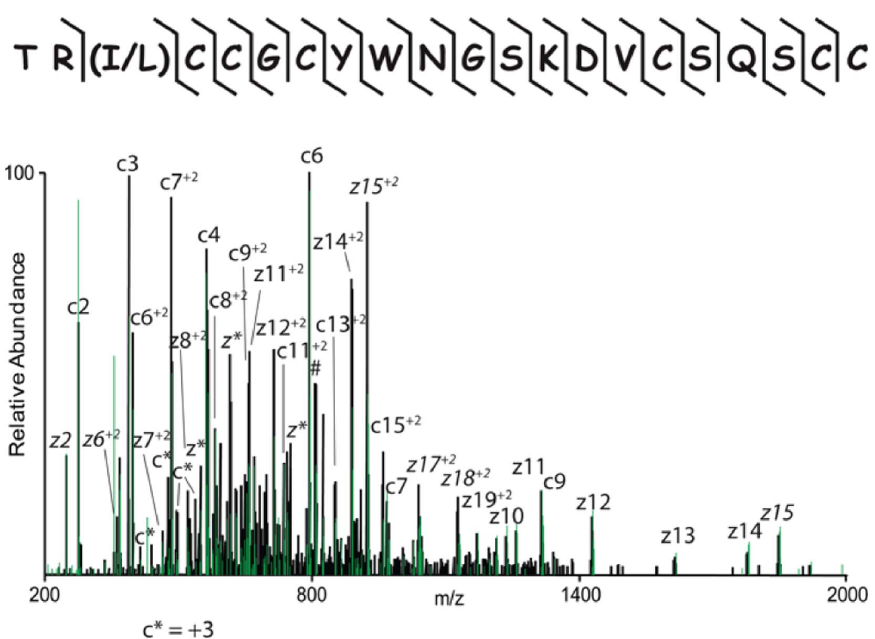
Figure 2. Sequence identification of Tv1 teretoxin. Shown is the native toxin (black) and the synthesized toxin (green) MS/MS spectrum recorded on a (M + 6H) + 6 ion after conversion of cysteine residues to dimethyl lysine analogs. Note the overlap of all major fragment ions. The sequence is given above the spectrum and observed c and z-type fragment ions are indicated in the sequence with z and y , respectively. Doubly charged fragment ions of type c and z are labeled with + 2, triply charged ions are of type c and z are indicated with *, z-type fragment ions that resulted from cleavage at cysteine with subsequent loss of the cysteine side chain are denoted in italic [60] and charge reduced species are labeled in the spectrum with # . The spectrum was recorded at a resolution of 7500 at m/z 400 and all fragment ions have a mass accuracy of better than 5 ppm.